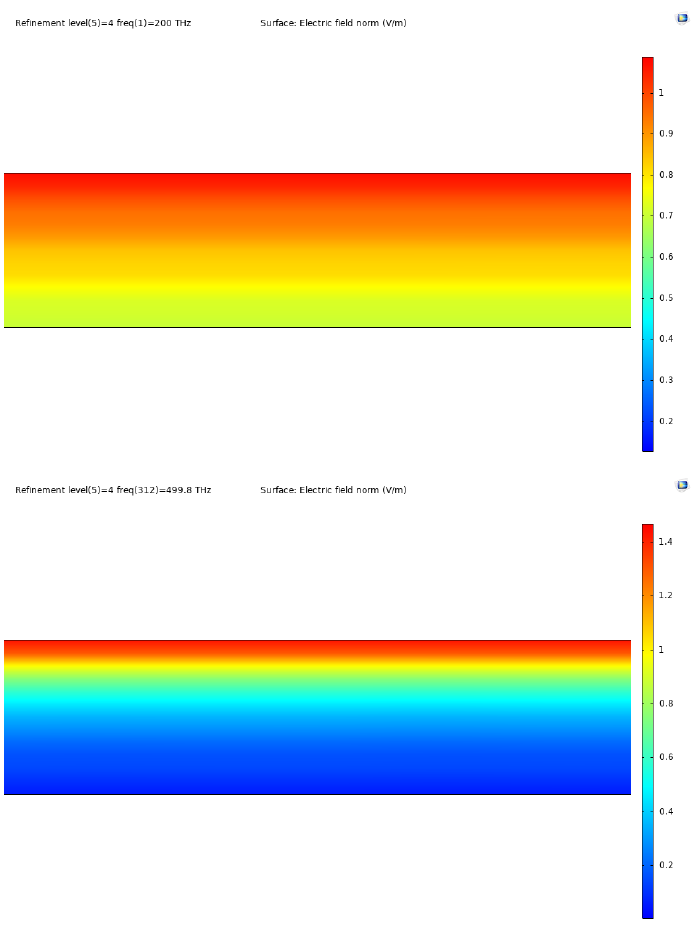
Figure A3. Electric field norm of Ga 0.84 In 0.16 As at 200 THz and 500 THz.